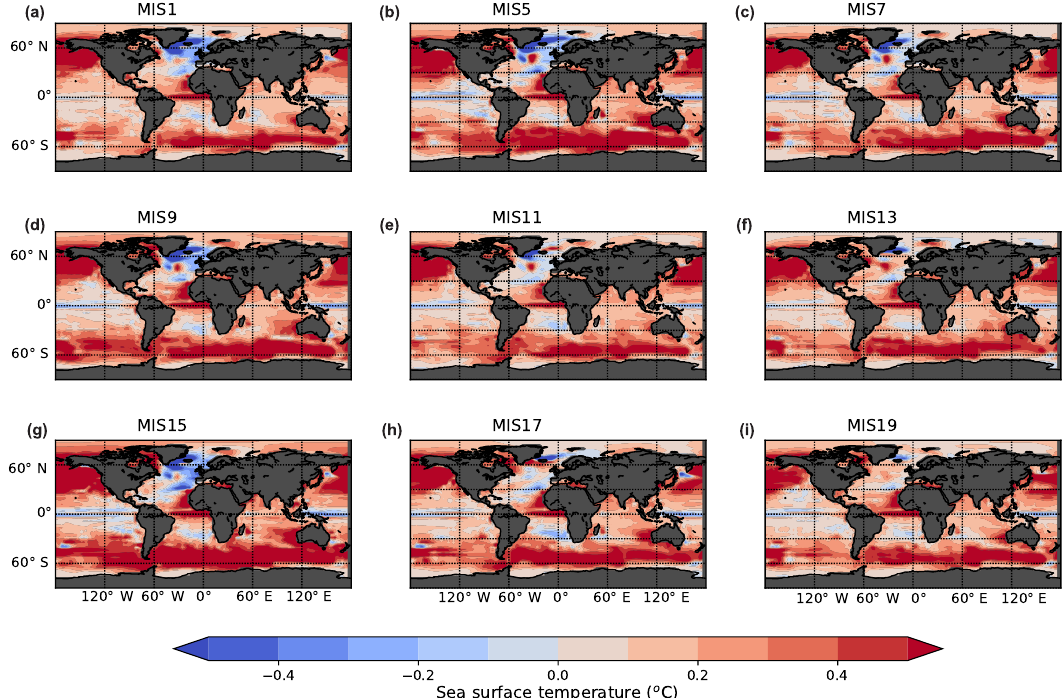
Figure 8. Annual SST difference ( ◦ C) between simulations with interactive vegetation (OVC) and with fixed vegetation (OC).